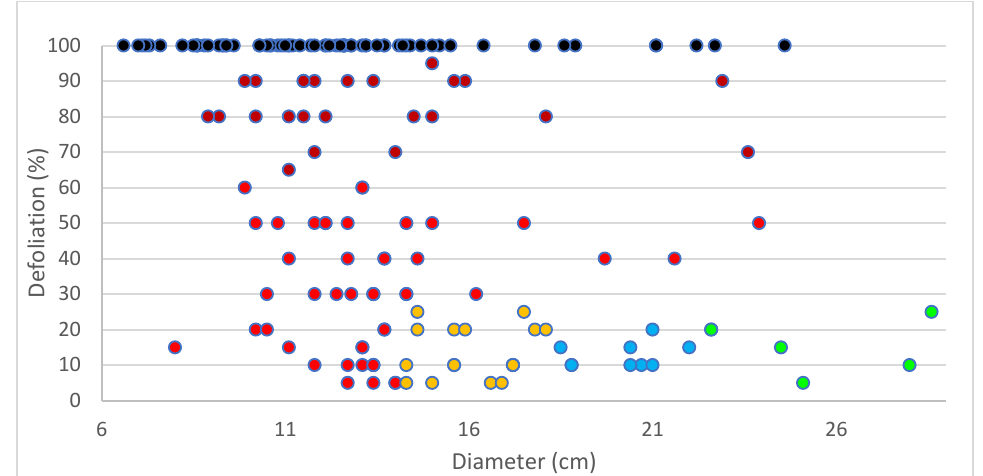
Figure 8. Selection of U. minor trees that are tolerant to O . novo-ulmi and the local environmental conditions (forest field) {I-green dots: D > Dm + 2 s, II-blue dots: D > Dm + s, III-orange dots: D > Dm, black dots: dead, brown dots: dying individuals, and red dots: not selected trees}.